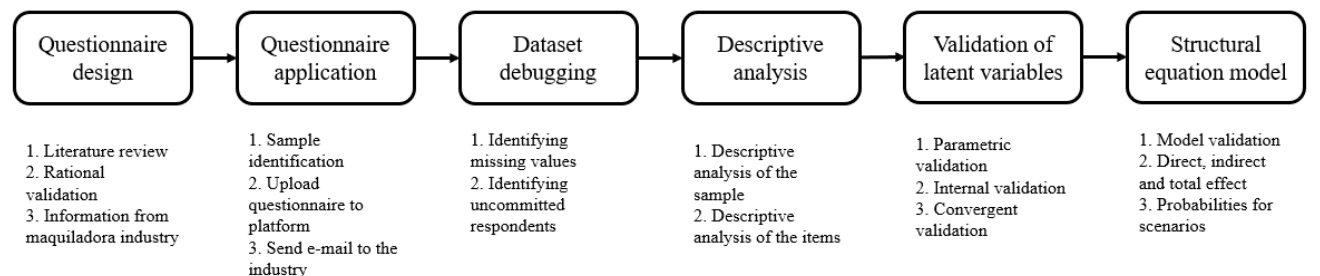
Figure 2. Research methodology.